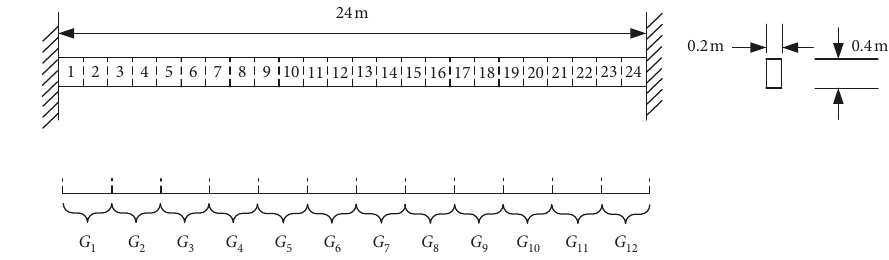
Figure 3: Schematic of the TCABC algorithm.